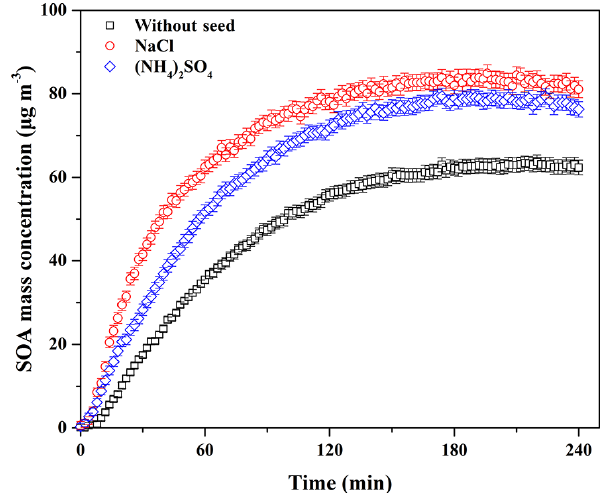
Figure 6. Time-dependent growth curves of SOA mass concentra- tion for guaiacol photooxidation in the presence of inorganic seed particles (Exps. 1, 4, and 7 in Table